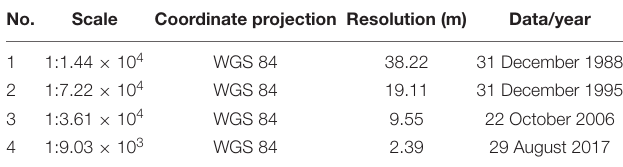
TABLE 2 | List of remote sensing data used in the